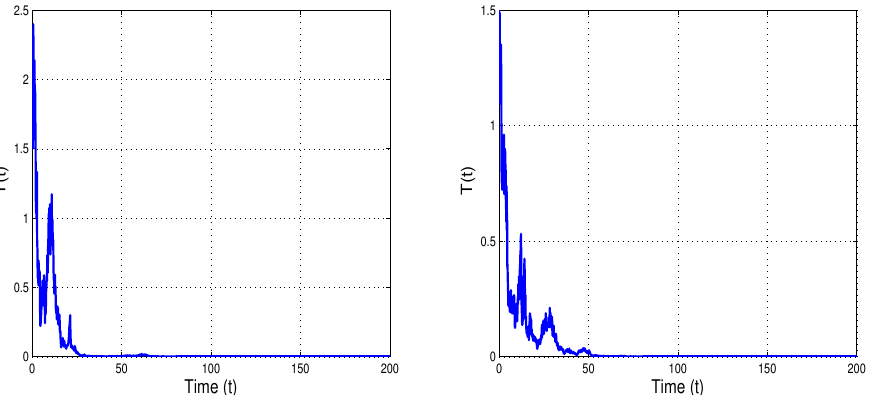
Figure 6. Shows time trajectories for tumor cells T ( t ) of the stochastic model (6) with k 1 = 0.7, k 2 = 0.3, d 1 = 0.7, d 2 = 0.3 ( right banner) and k 1 = 0.3, k 2 = 0.7, d 1 = 0.3, d 2 = 0.7 ( left banner) and 2 = − 0.125 < 0. The threshold conditions of extinction is verified based on Theorem 3. In it, a − σ 1 2 stochastic noise is shown to suppress the explosion of population